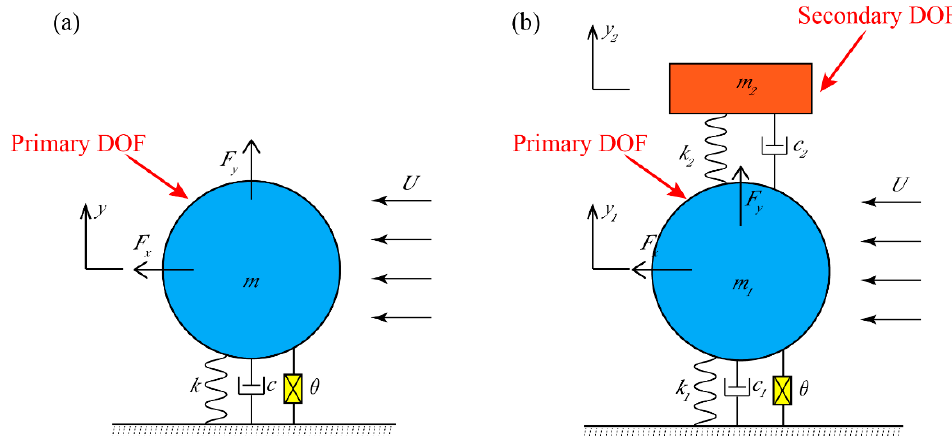
Micromachines 2022 , 13 , x Figure 1. ( a ) Conventional 1DOF VIVPEH; ( b ) 2DOF VIVPEH. Figure 1. ( a ) Conventional 1DOF VIVPEH; ( b ) 2DOF VIVPEH.